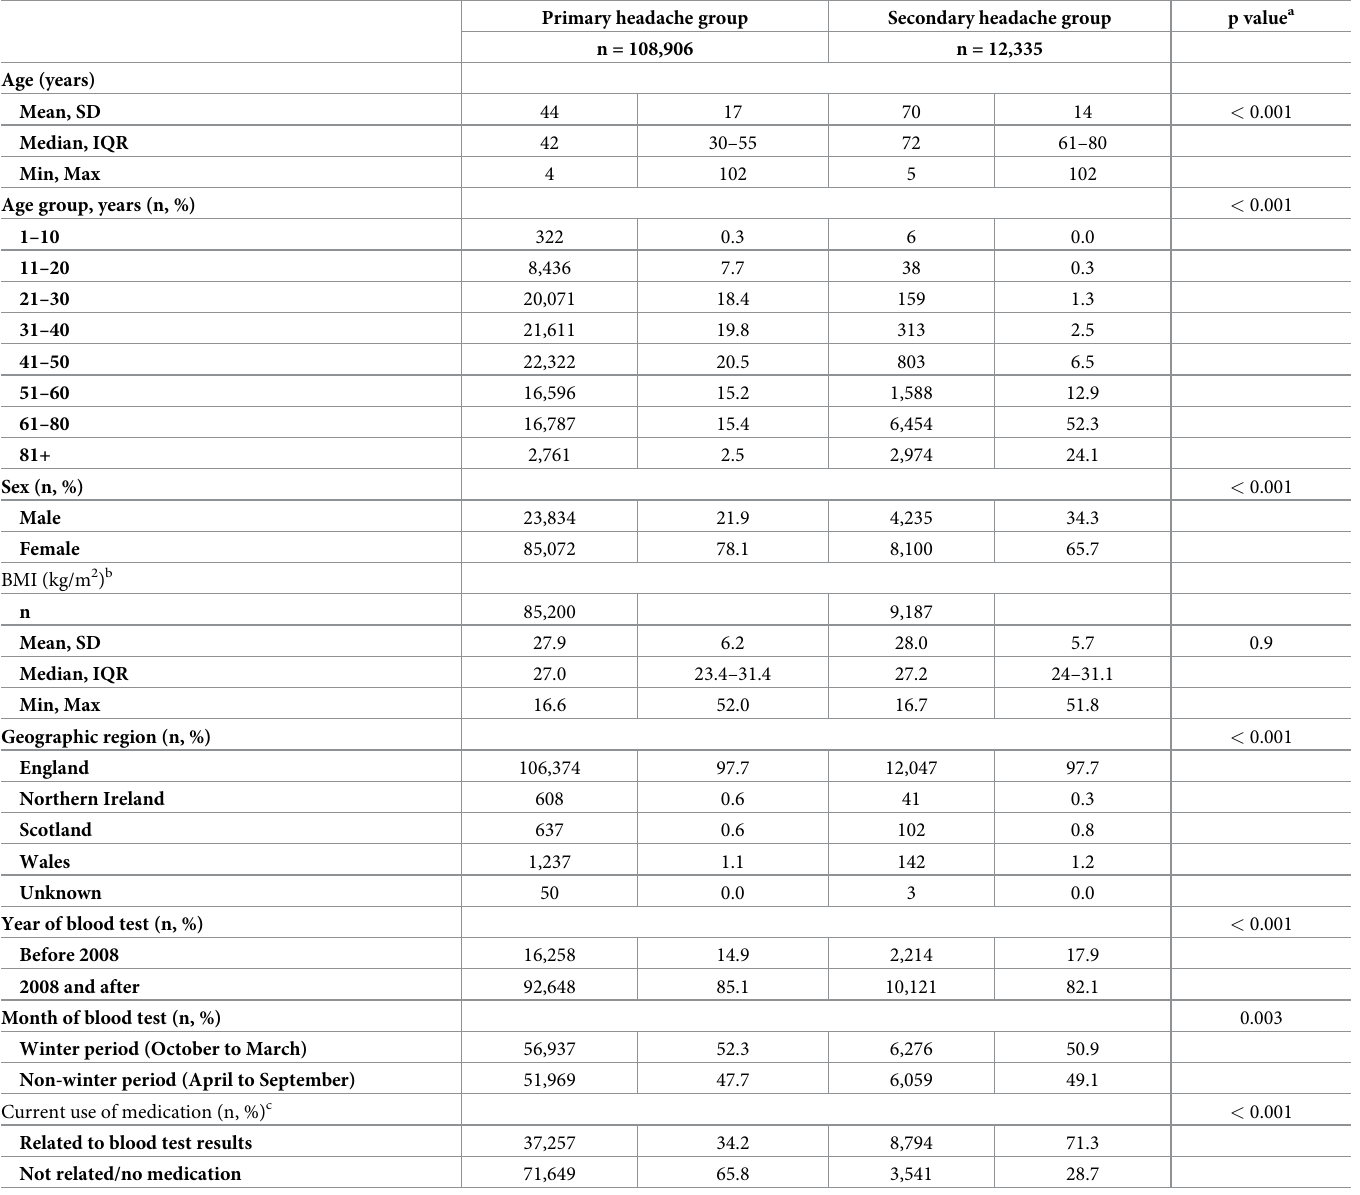
Table 1. Baseline demographic and clinical characteristics of the analytical cohort (n =